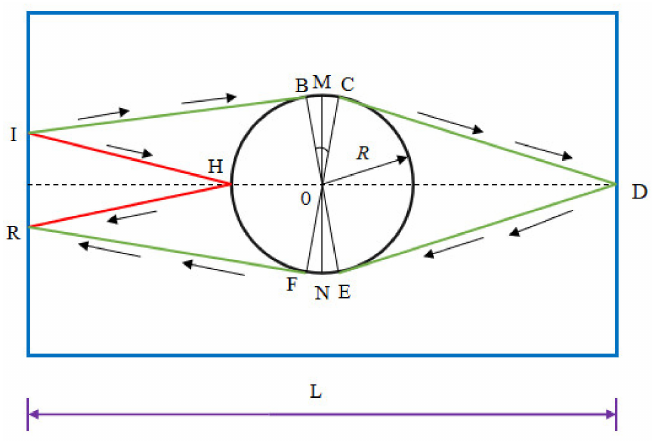
Figure 6. Empty estimation